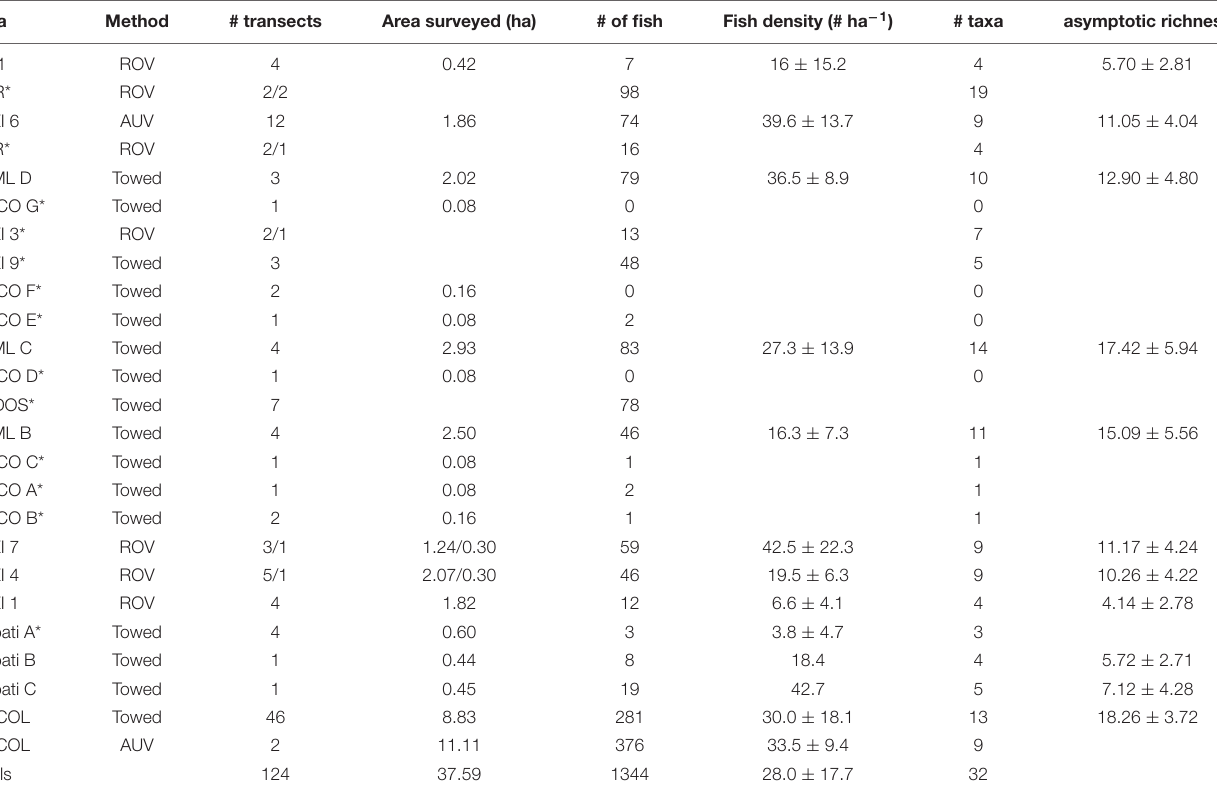
TABLE 1 | Camera survey areas, sampling metrics and associated estimates for fish density (mean ± std dev), number of taxa observed (see also Figure 3 ), and asymptotic taxa richness (see section “Materials and Methods”) with 95% confidence intervals (for quantitative transects).